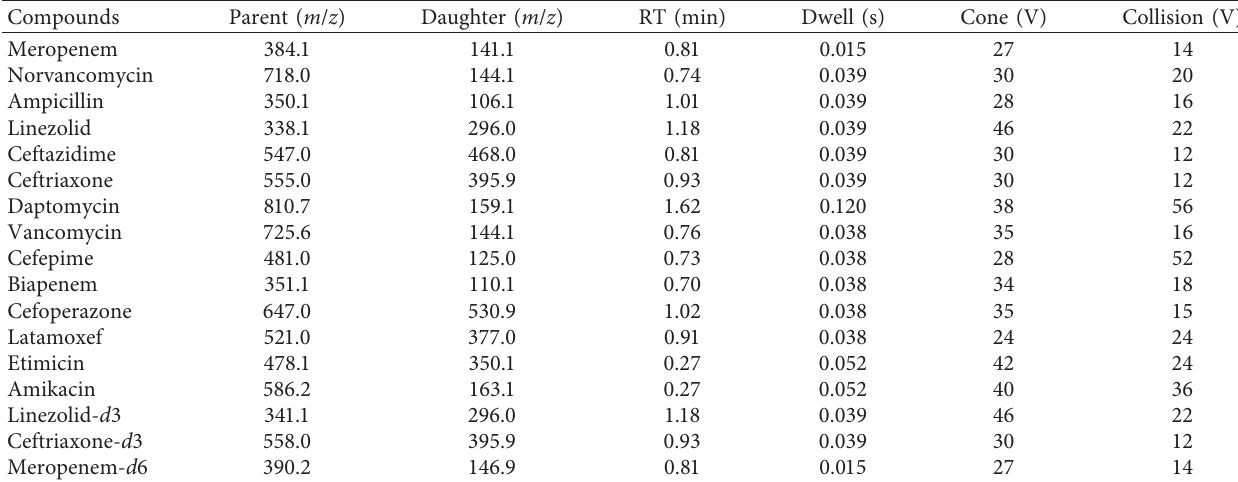
Table 1: Acquisition parameters used in the UPLC-MS/MS